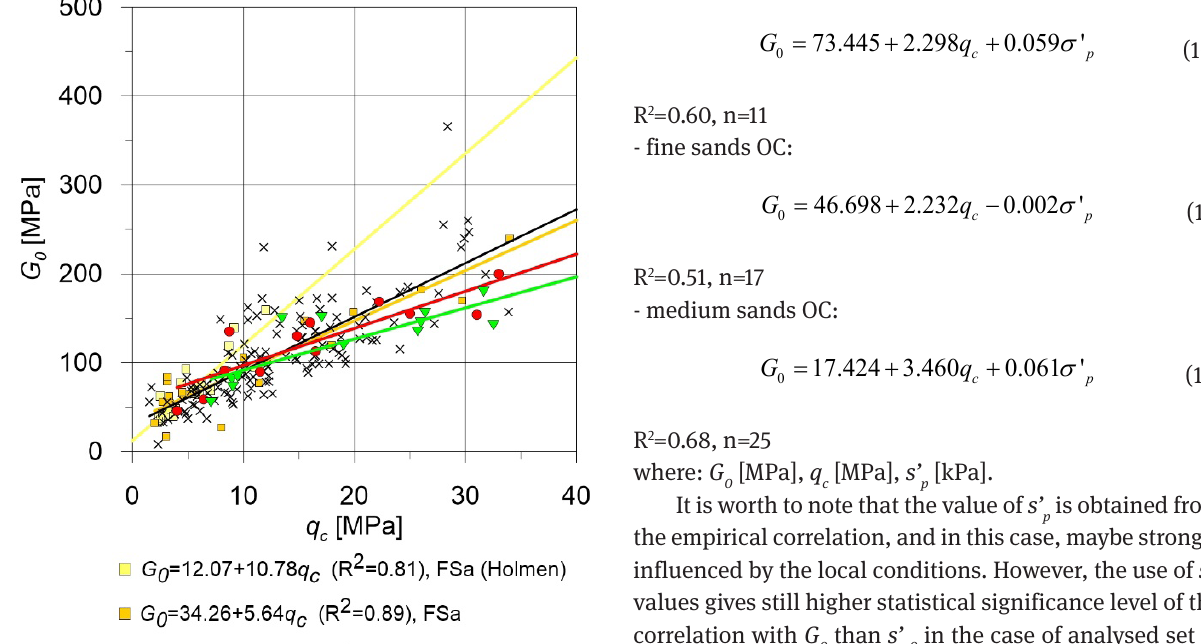
Figure 9: The correlation between modulus G for normally consolidated soils taking into account the type of soil.